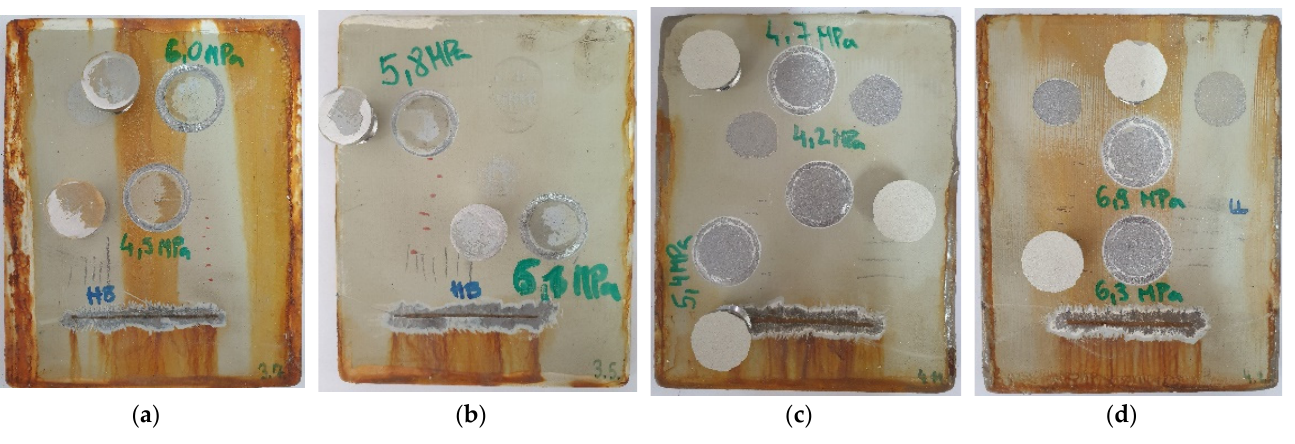
Figure 3. Pull-off testing on coated samples after 720 h of exposure in a salt spray chamber according to ISO 4624. Samples are represented as A1 ( a ), A2 ( b ), B1 ( c ) and B2 ( d ), according to the Table 2.